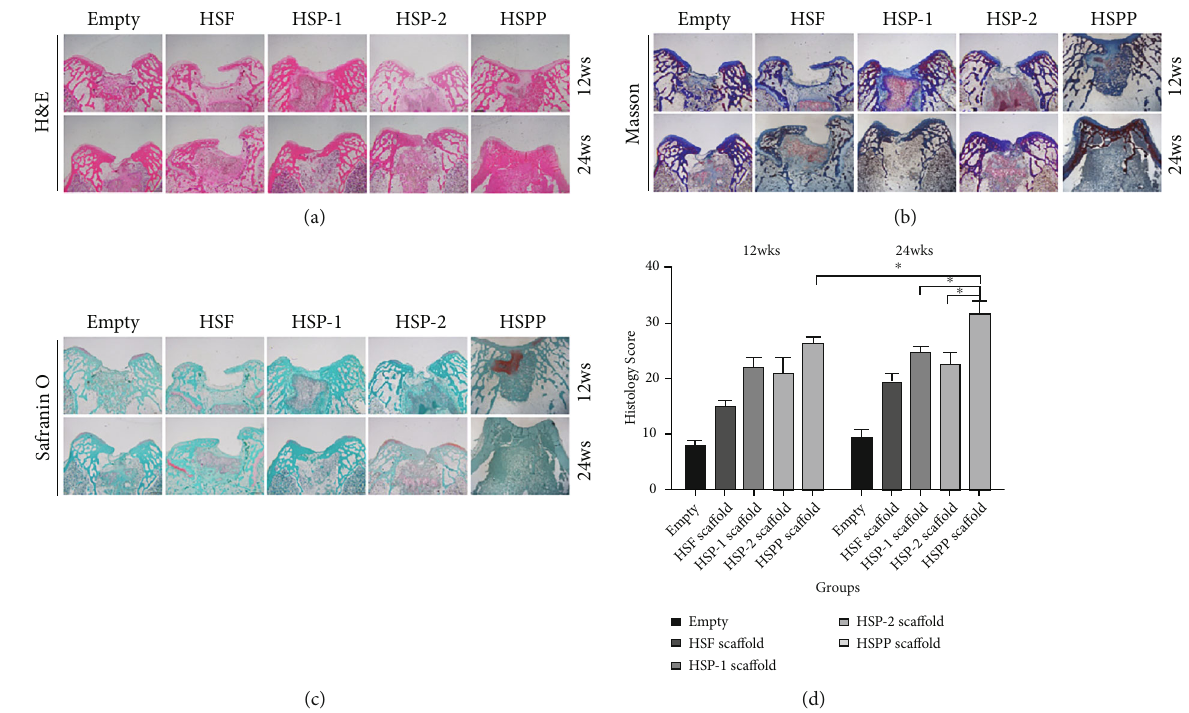
Figure 10: Histological evaluation of cartilage repair with di ff erent sca ff olds in osteochondral defect models. (a) H&E staining. (b) Masson staining. (c) Safranine O fast green staining. (d) Histological scores at 12 and 24 weeks in each